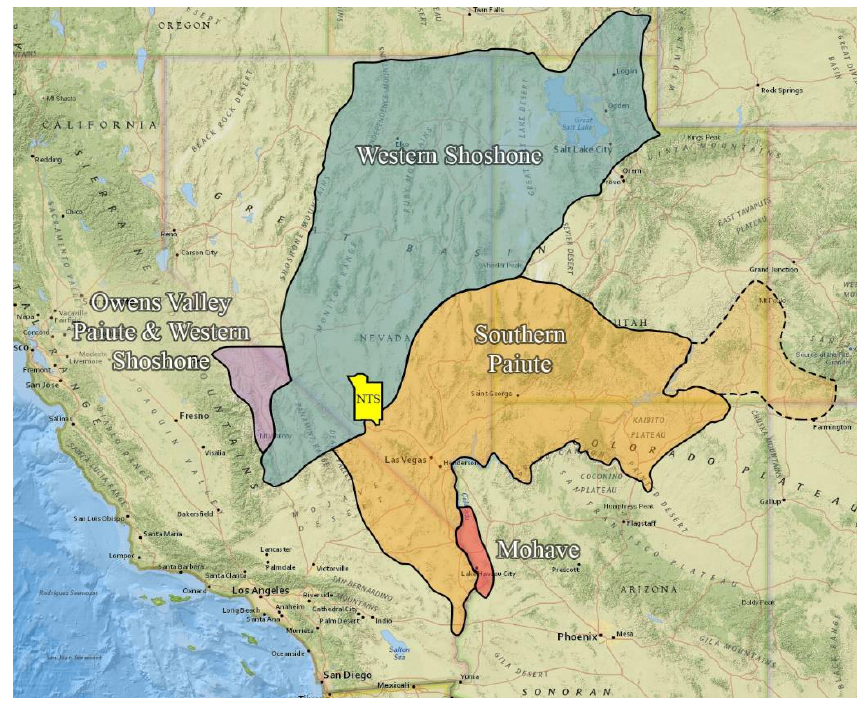
Figure 1. Map of Aboriginal Lands of Nellis Consulting Group of Tribes and Organizations.